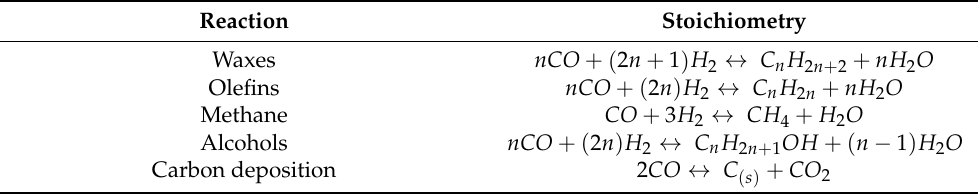
Table 24. Main reactions and products involved in CO 2 hydrogenation